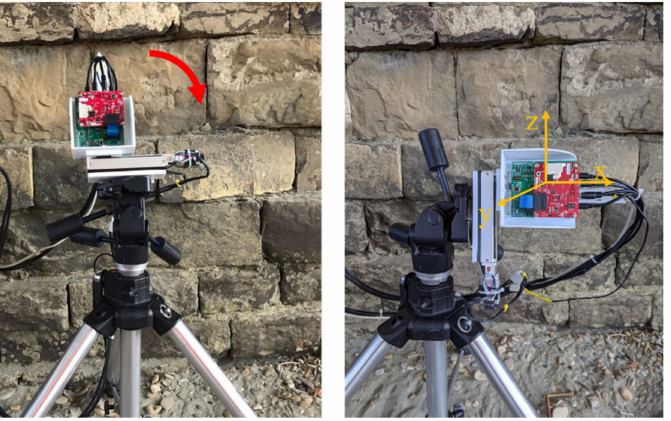
Figure 19. Radar setup for dynamic test.